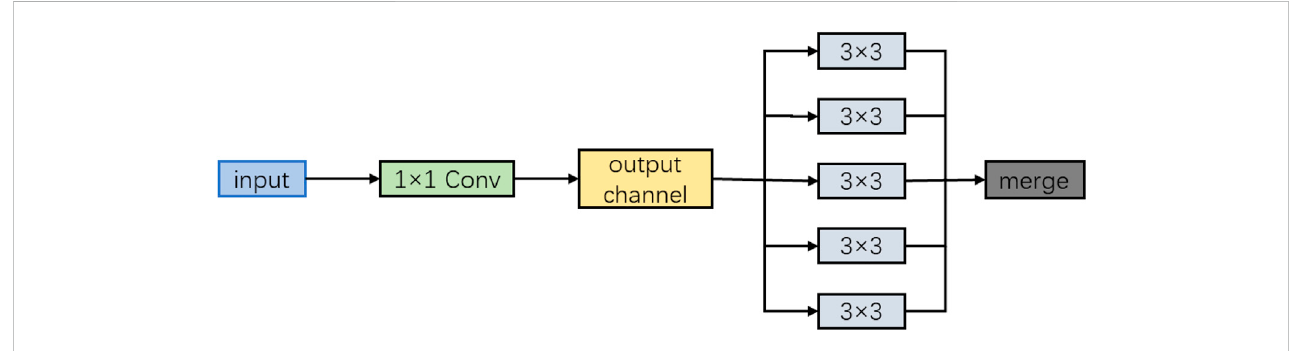
FIGURE 3 Schematic diagram of